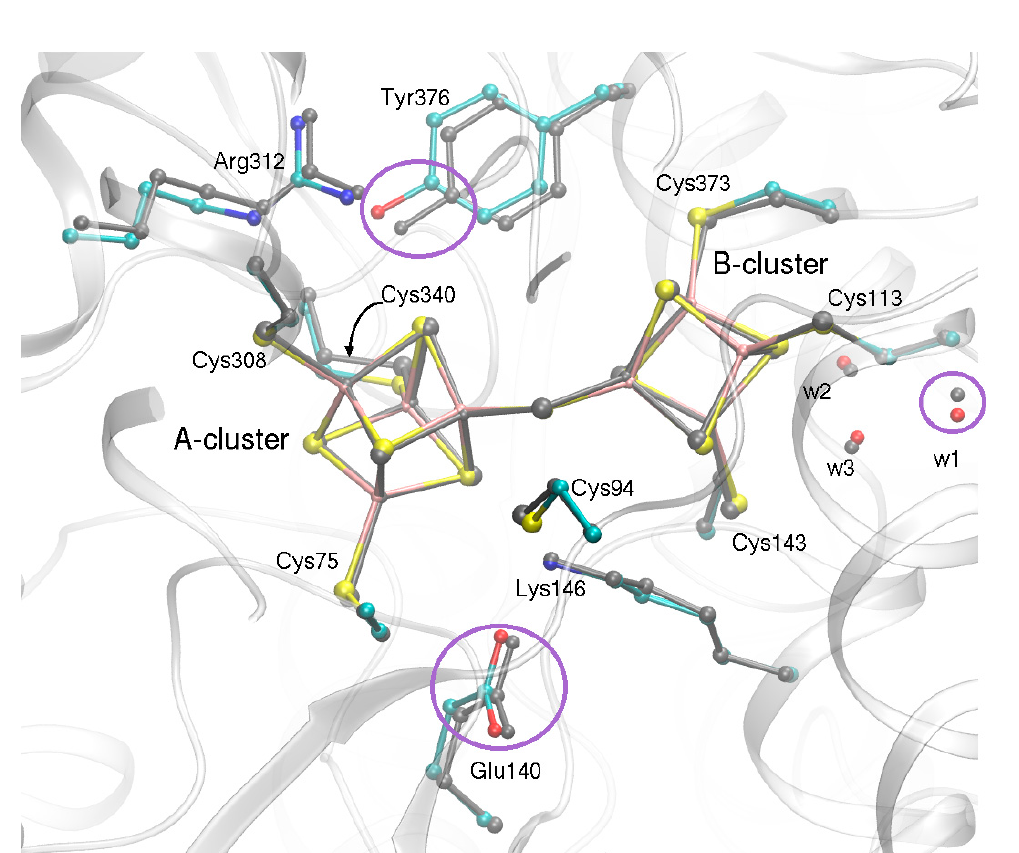
Figure 6. For BS25, the QM/MM geometry optimized active site (in color) is compared to the crystal structure geometry (PDB: 6ENO) [1] (in grey). In the QM/MM geometry optimized structure, iron atoms are colored pink, sulfur atoms are colored yellow, carbon atoms cyan, nitrogen atoms blue, and oxygen atoms in red. Hydrogen atoms are omitted for clarity. Purple circles are drawn around larger structural changes. Figure drawn using VMD and TGIF.